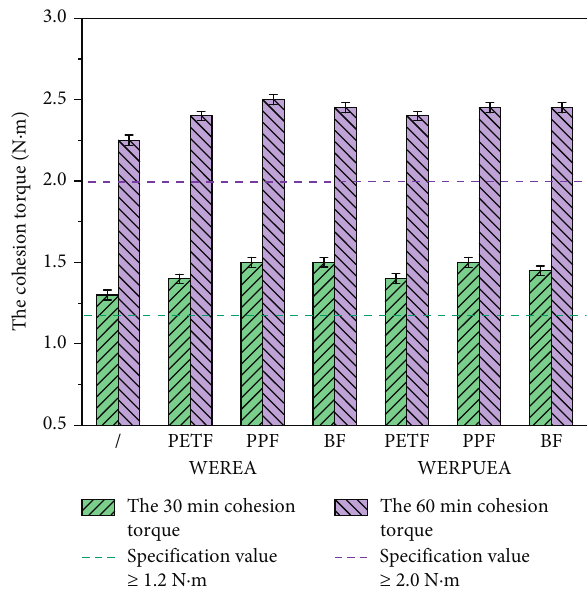
Figure 6: The cohesion torque of different types of microsurfacing.